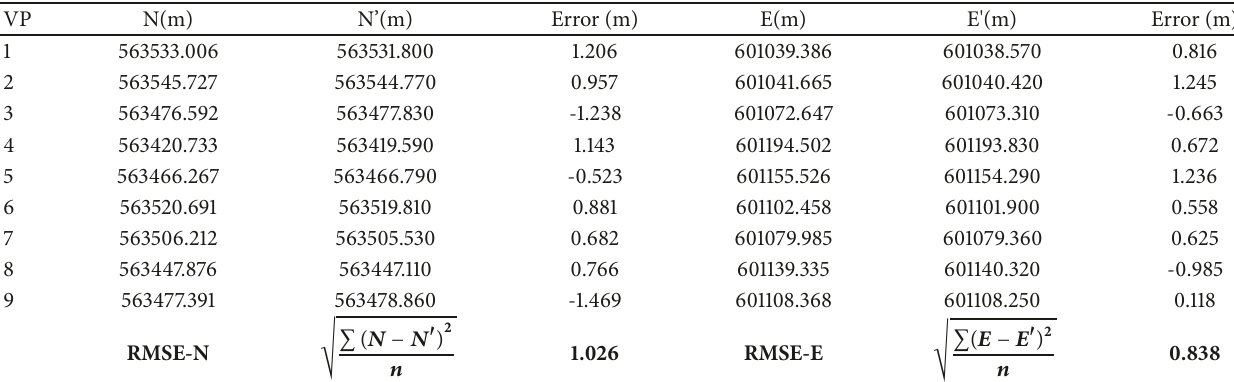
Table 4: Error and root mean square error for northing and